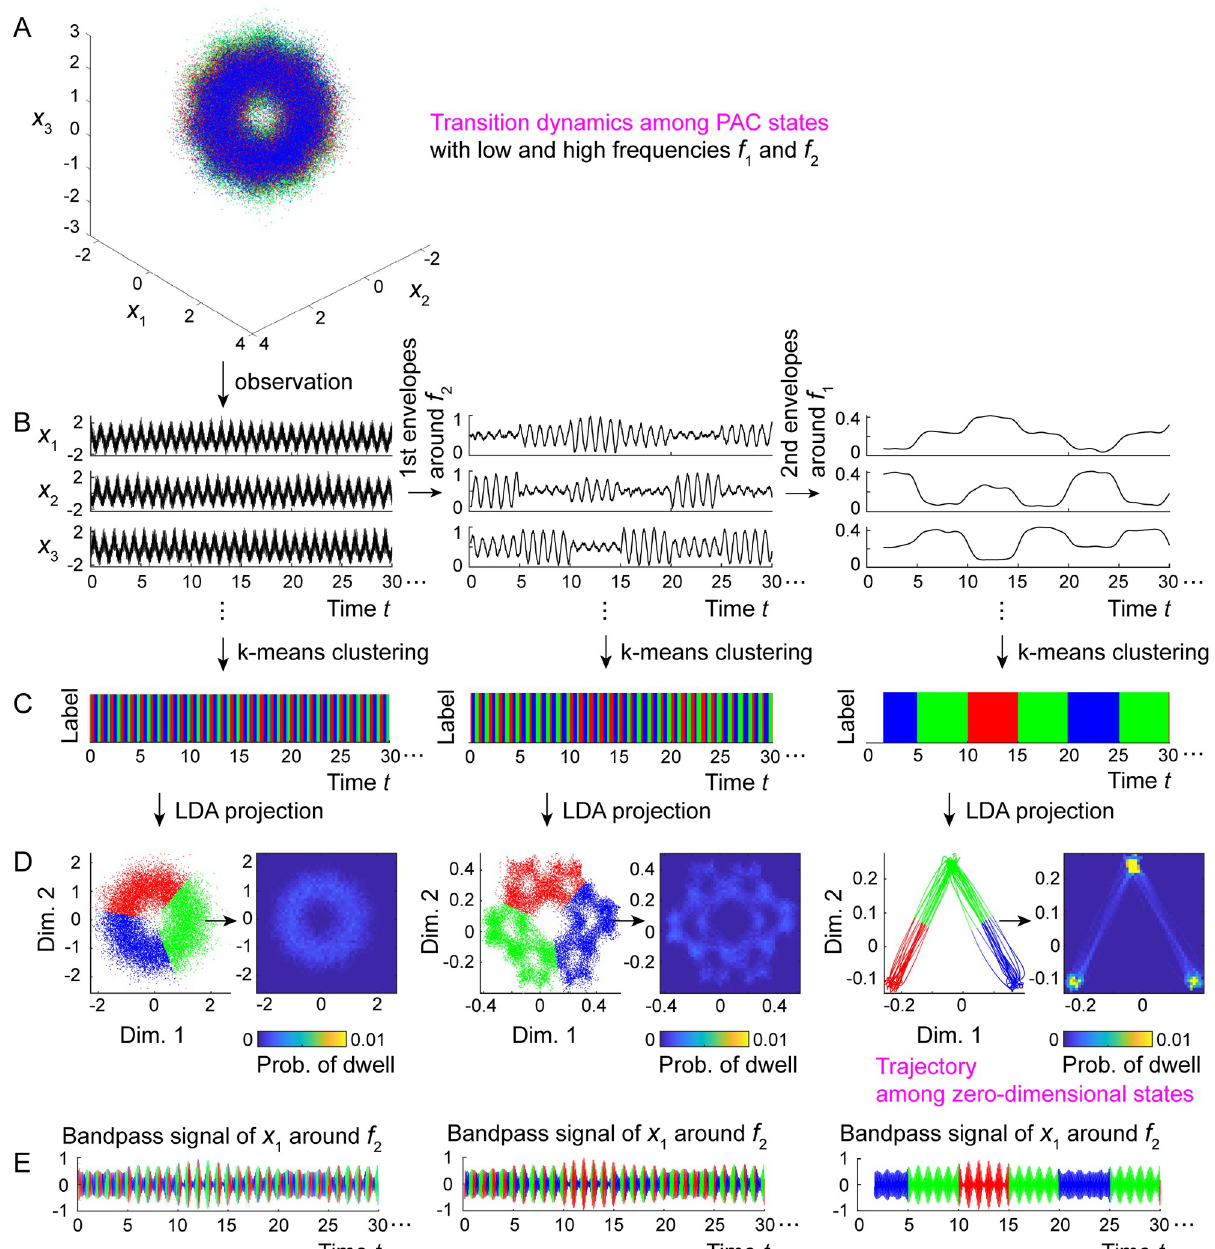
Fig 2. The flow of signal processing in metastable states clustering. (A) A transition dynamics among three PAC states ( d = 2) in the state space of x i ( t ) = cos(2 πf 1 t + ψ i ) + 0.5[1 + b i ( t ) cos(2 πf 1 t + ψ i )] sin(2 πf 2 t ) + ξ i ( t ), where the first, second, and last terms indicated the slow oscillations, amplitude- modulated fast oscillations, and noise, respectively. (B) Observed signals, the first envelopes (instantaneous amplitudes) around f 2 , and the second envelopes around f 1 . (C) The labeled sequences. (D) LDA projections of the state space. (E) The bandpass signal of x 1 ( t ) around peak frequency f 2 and corresponding labels. The frequencies f 1 and f 2 here were set to 1 Hz and 10 Hz, respectively; modulation index b i ( t ) dynamically changed among strengths 0.15, 0.5, and 0.85; and noise ξ ( t ) followed a normal distribution of mean 0 and standard deviation 0.3. The colors in panel A correspond to i those in the right column of panels C to